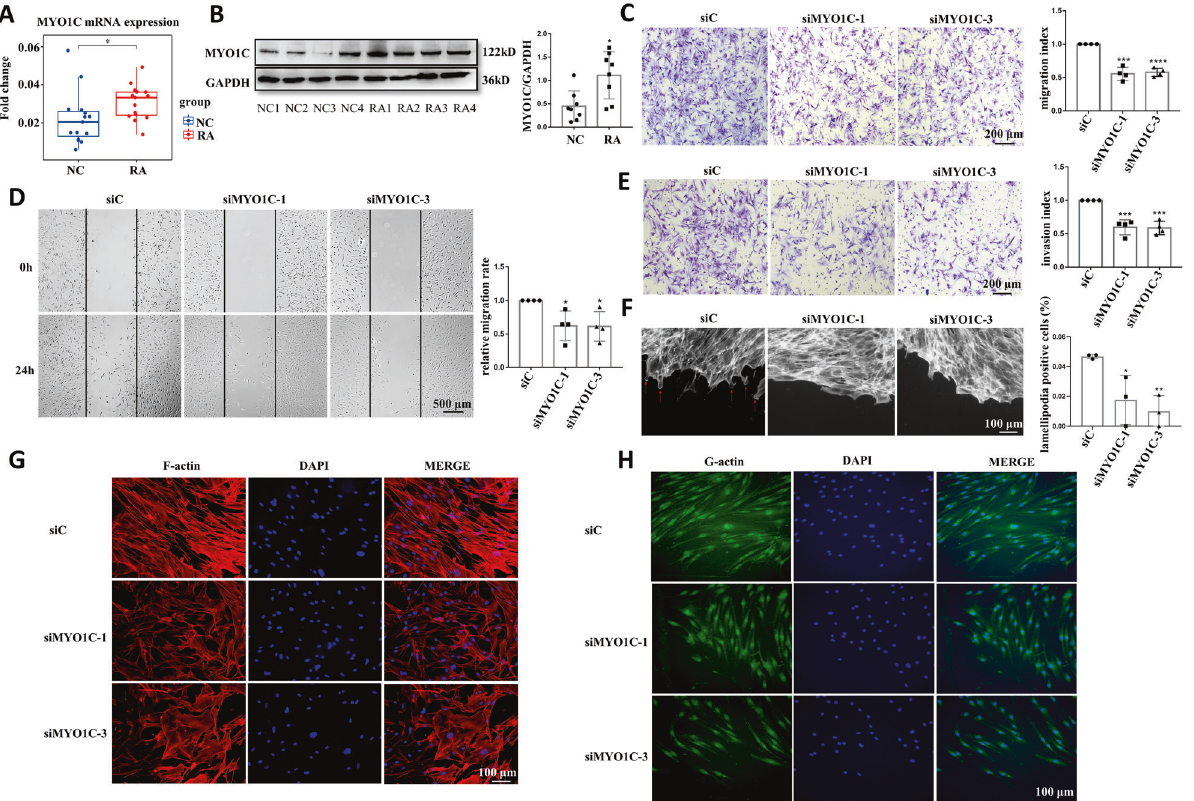
of migrating cells in the siMYO1C group normalized to that in the siC group) in each group. D Wound-healing assays were used to evaluate cell migration. Representative images (original magni fi cation, ×40) are shown. The graphs show the relative migration rates (the number of